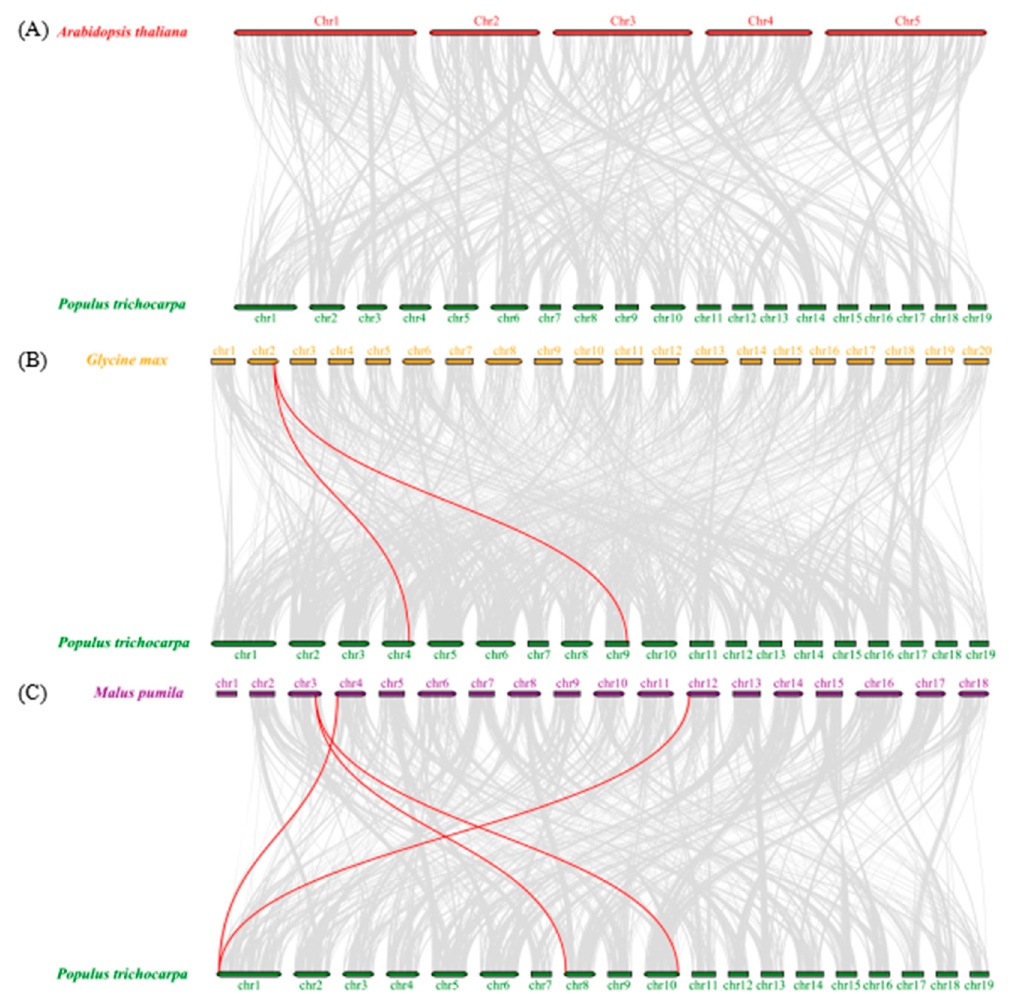
Figure 7. Synteny analysis of EIN3/EIL genes between Populus × xiaohei and other plants. ( A ) Di- cotyledonous plant A. thaliana . ( B ) Dicotyledonous plant G. max . ( C ) Dicotyledonous plant M. pumila . Gray lines in the background indicate collinear blocks within Populus × xiaohei and other plant genomes; red lines indicate syntenic EIN3/EIL gene pairs.